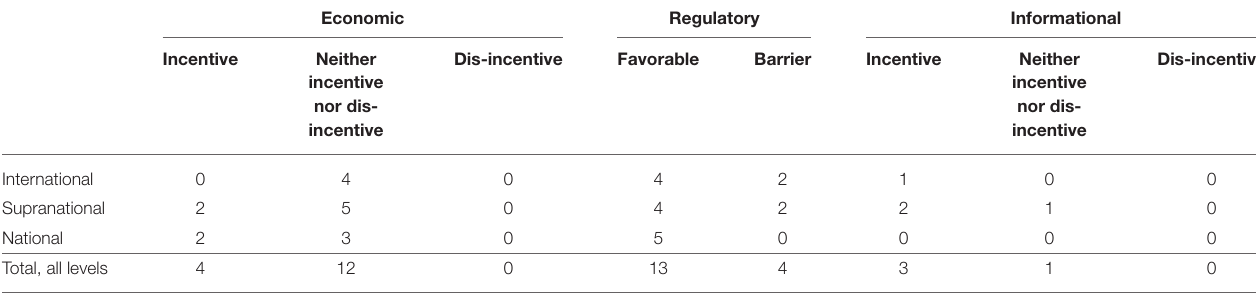
Dis-incentive incentive nor dis- incentive